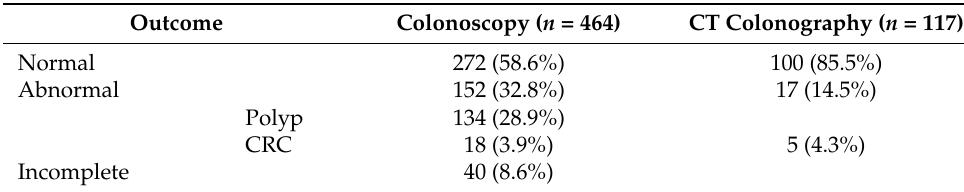
Table 2. Clinical tests and summary findings were performed on enrolled patients. CTC–CT colonog- raphy. CRC—colorectal cancer. Data are numbers of patients.